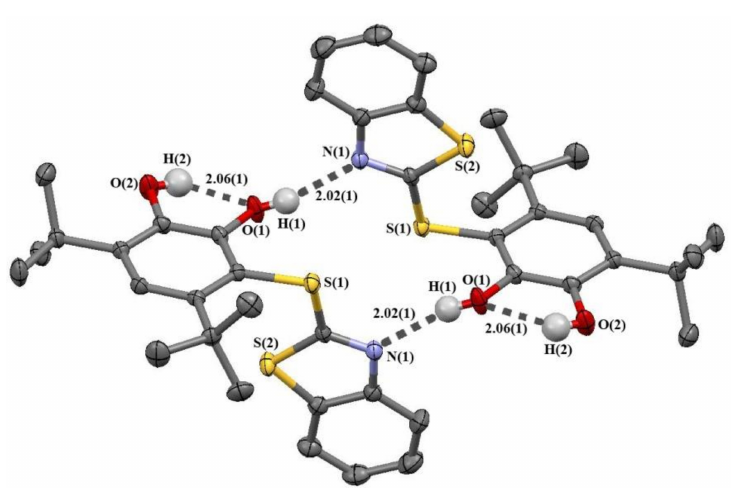
Figure 4. Intra- and intermolecular hydrogen bonds in the crystal of catechol 15 . Hydrogen atoms (except for hydroxyl ones) are